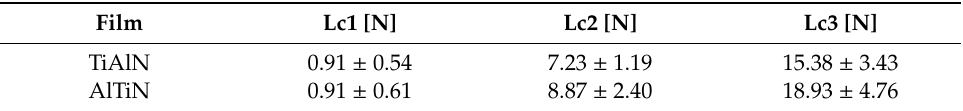
Table 2. Film critical loads estimated by scratch test (Figure 3): Lc1—first symptoms of cohesive failure (angular or parallel cracking), Lc2— beginning of adhesive failure (buckling, chipping, spalling, etc.), Lc3—total failure of the coating or massive exposure of the substrate (mean ± SD).